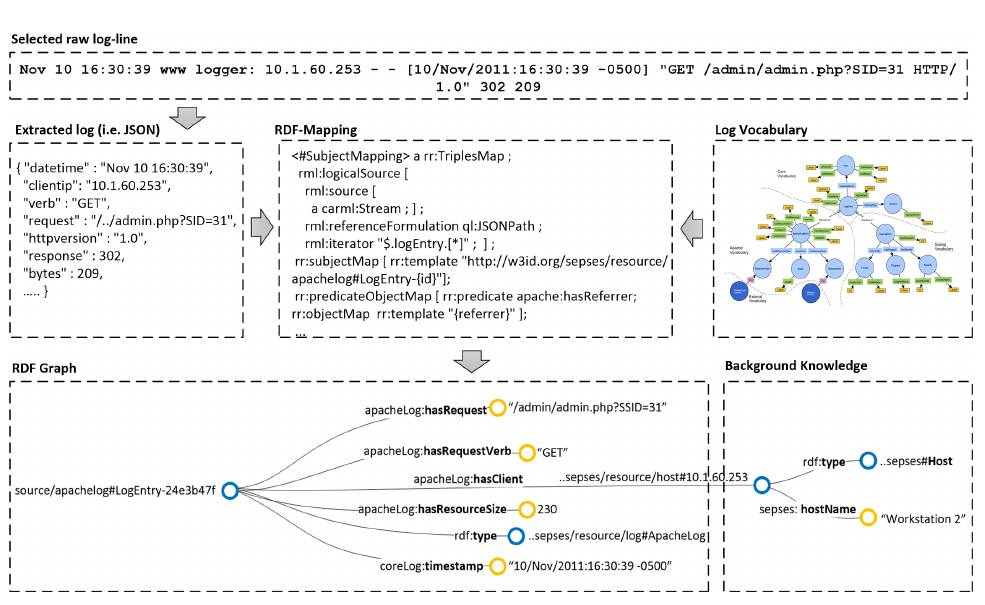
Figure 6. Log graph generation